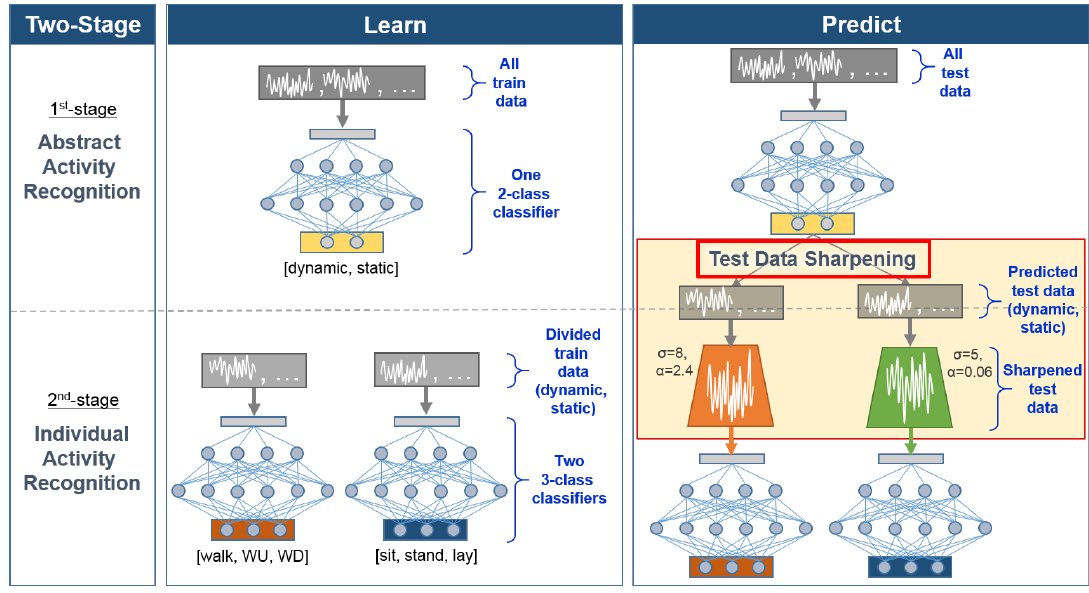
Figure 2. Overview of our divide and conquer-based 1D CNN HAR with test data sharpening. Our approach employs two-stage classifier learning during the learning phase and introduces test data sharpening during the prediction